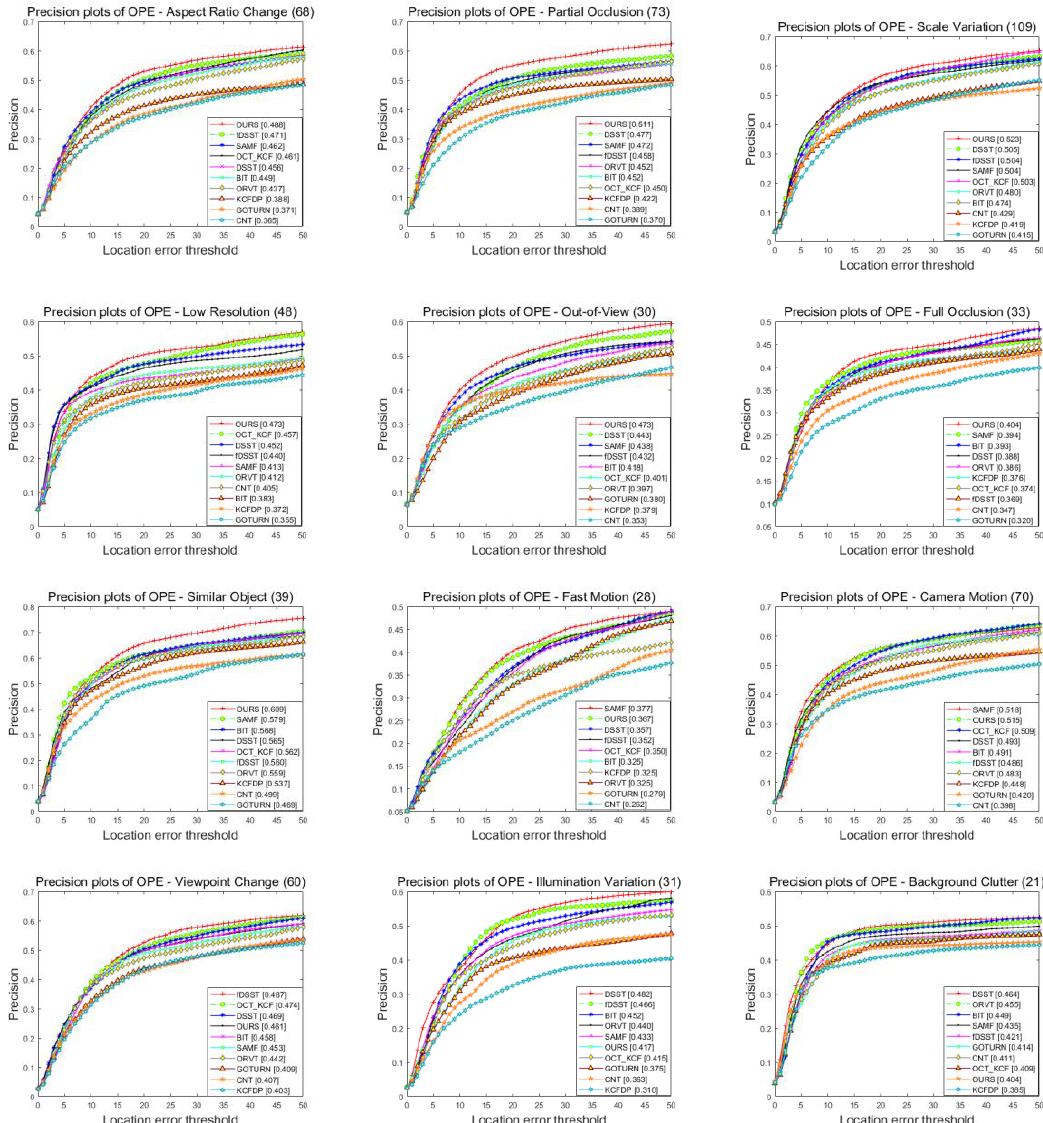
Figure 7. Precision plots of our tracker compared with state-of-the-art approaches on UAV123 dataset. Table 1. Overall precision rates on different attributes, where the entries in red denote the best results and the ones in green indicate the second best.